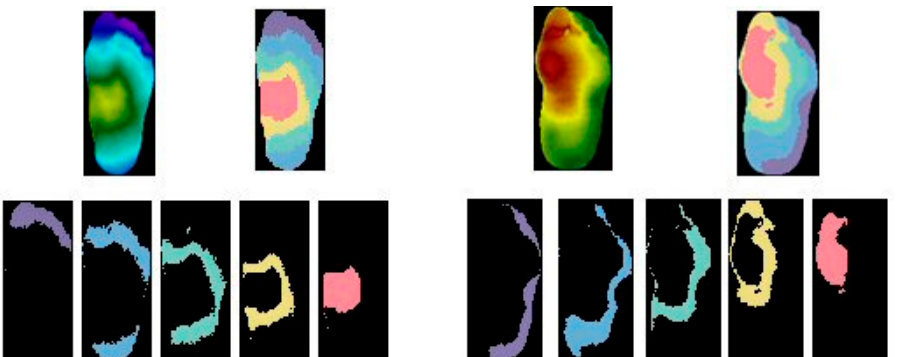
Figure 2. Thermogram division in clusters. First row: RGB representation of thermal image and the clusters image representation, in non-diabetic ( left ) and diabetic ( right ); Second row: the 5 individual clusters.